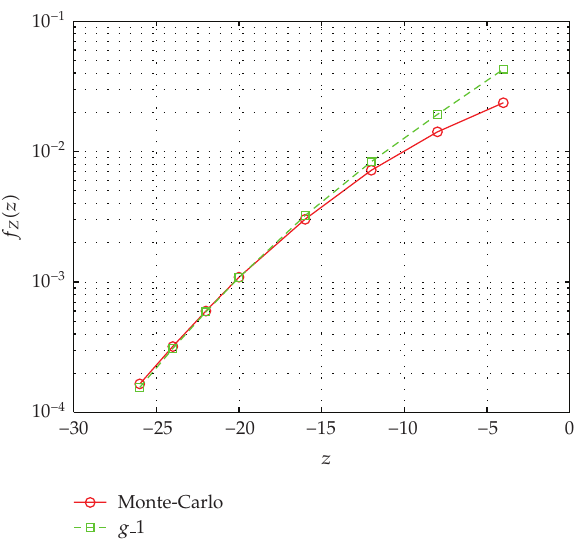
Figure 1: Left tail f Z , ρ < σ 1 /σ 2 . g 1 is the approximation.